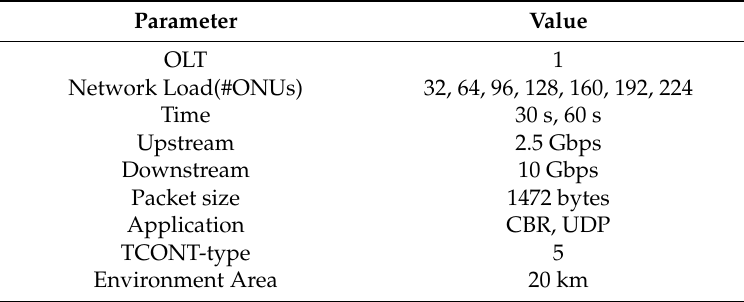
Table 3. Description of Simulation